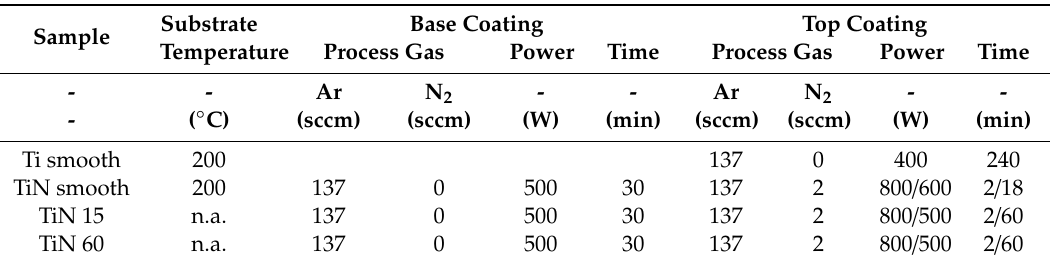
Table 1. Parameters of the PVD processes for the deposition of Ti, as well as smooth and nanorough TiN.